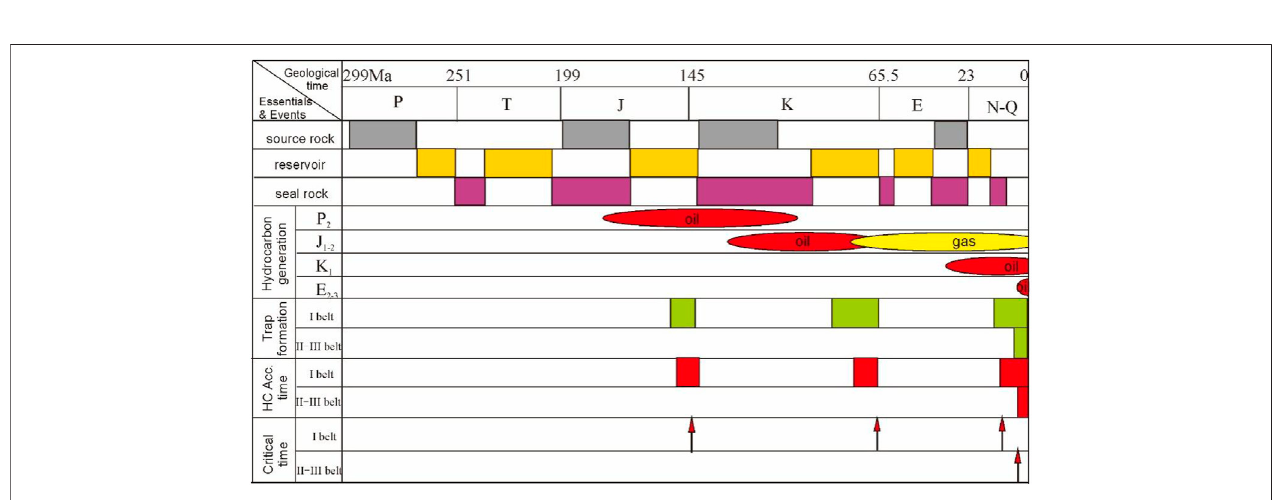
FIGURE 14 | Schematic diagram of hydrocarbon accumulation events in the South Junggar foreland basin. The four sets of source rock have different time for oil and gas generation and the different trap formation and hydrocarbon accumulation time between the fi rst and second-third row of anticlines.